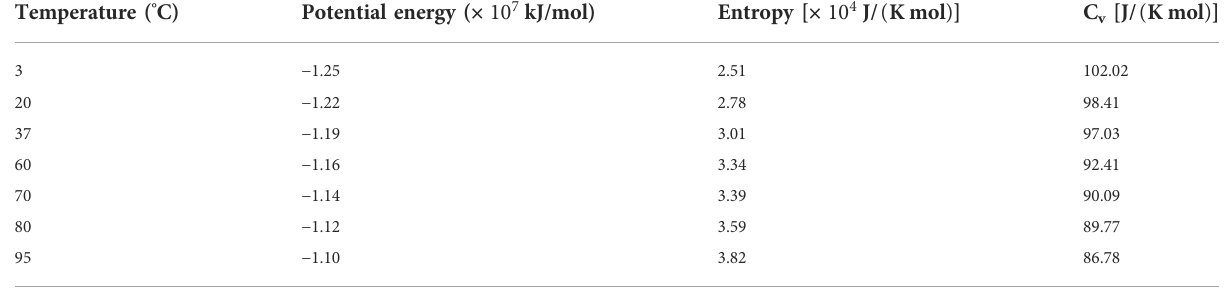
TABLE 2 The averaged potential energy, entropy, and isochoric heat capacity for each temperature.